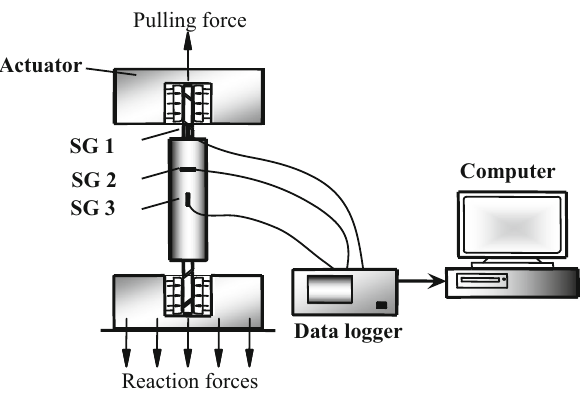
Fig. 6 Instrumental setup for tensile